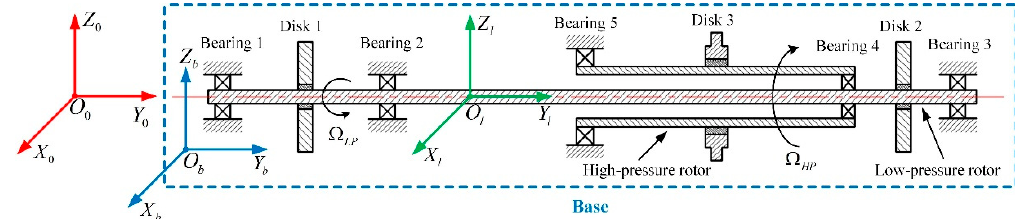
Figure 1. A dual-rotor system on a moving base with various coordinate systems.